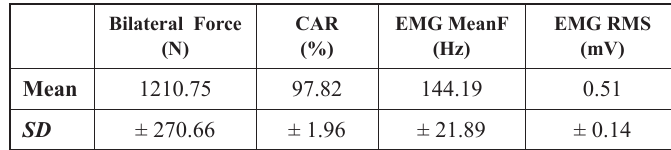
Table 3. Effect of Sustained Maximal Isometric Bilateral Contraction of Homologous Vastus Lateralis Muscles on Bilateral Force, CAR, EMG Mean Frequency, EMG Amplitude. * p < .05 compared with SC begin